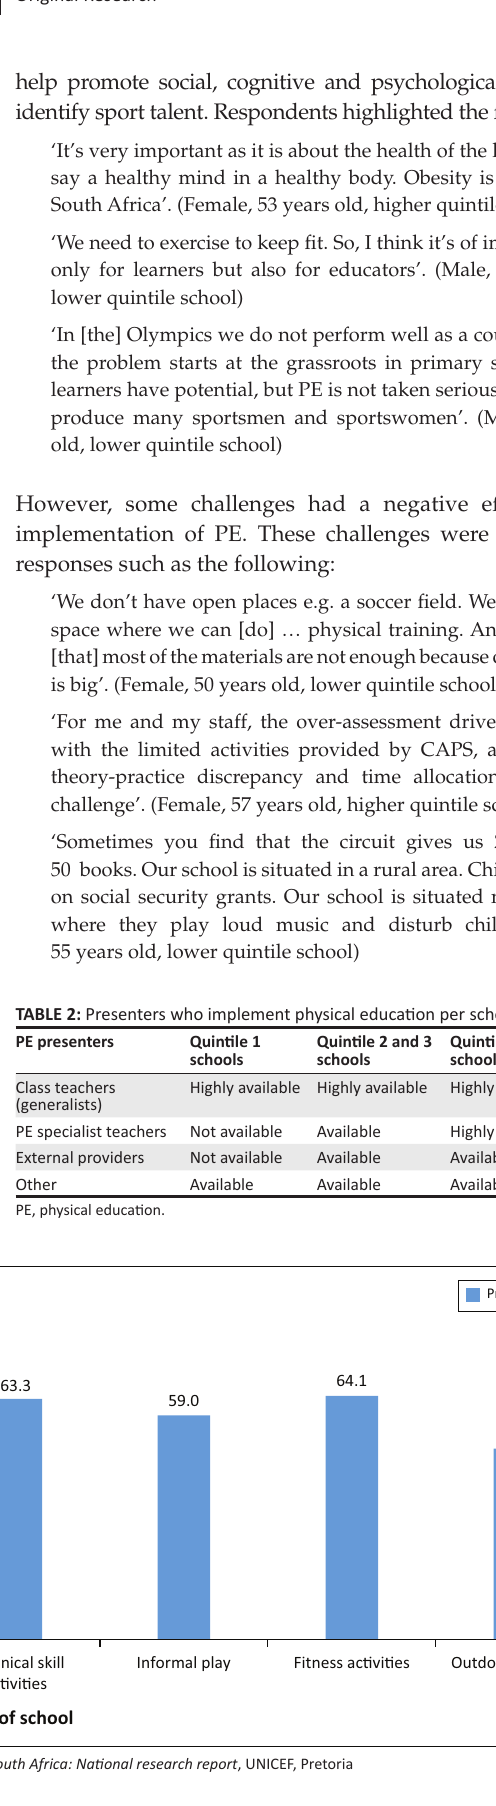
FIGURE 4: Physical education activities offered in schools.